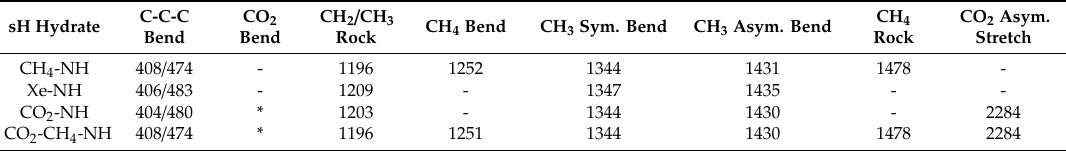
Table 3. Convoluted IR spectra peak frequencies (cm − 1 ) of guest vibrations in sH gas hydrates at equilibrium (0 K, 0